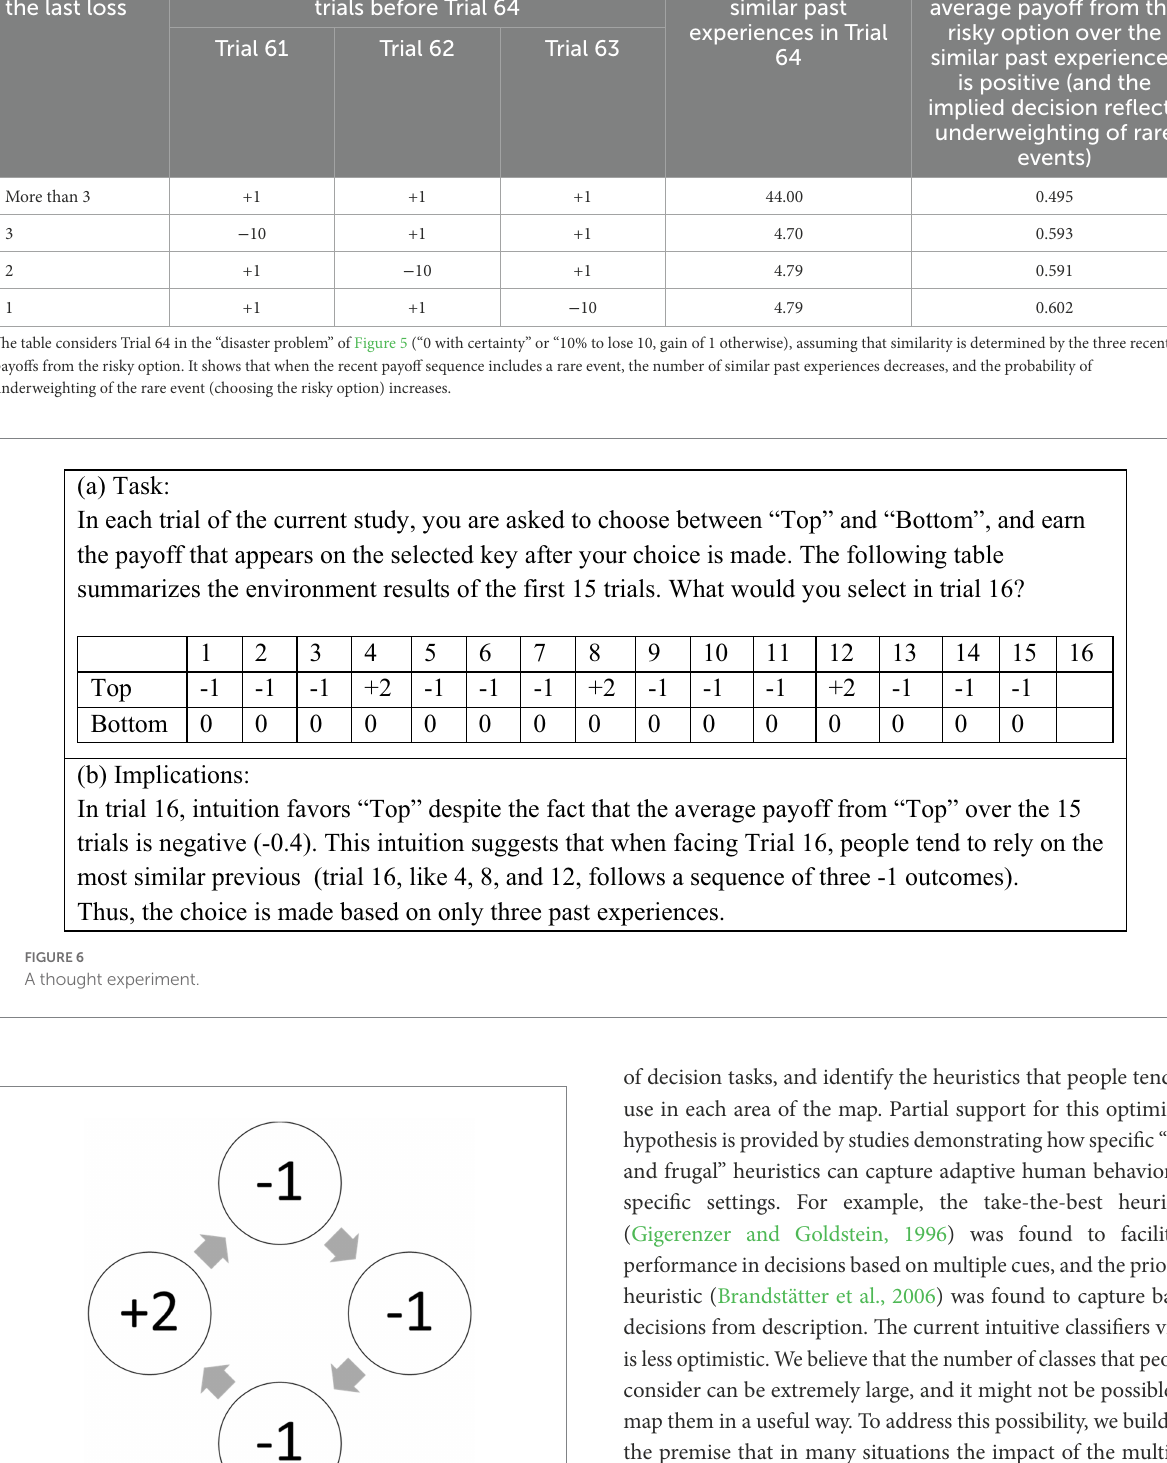
TABLE 1 Demonstration of the implications of sequence-based similarity rules. The payoff from the risky option in the three trials before Trial 64